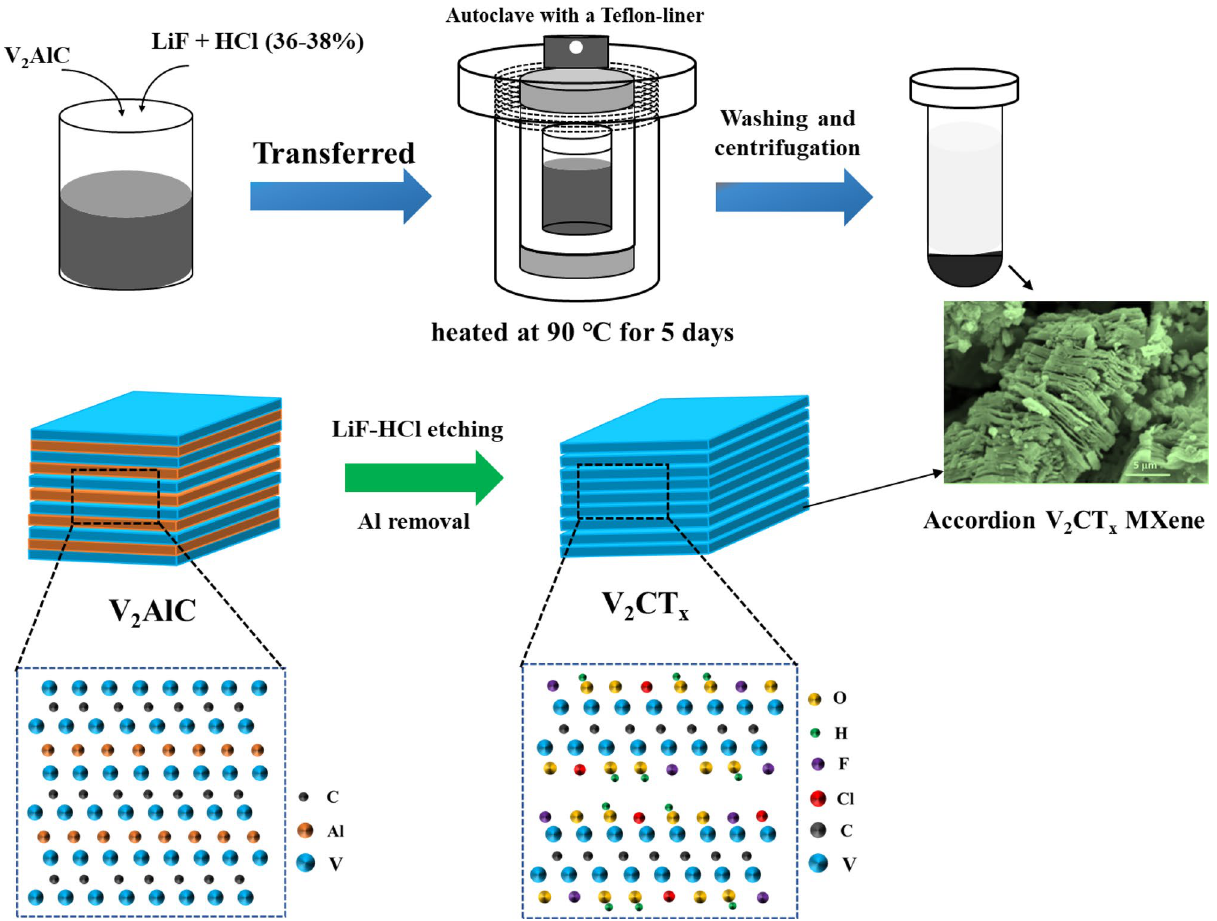
Figure 1. Schematic illustration of the synthesis process of accordion-like V 2 CT x MXene from V 2 AlC MAX- phase tively (as shown in Figs. 2 and 3). Figure 2a depicts the SEM image of the V 2 AlC MAX phase materials. As seen in the figure, the surface of the V 2 AlC MAX phase material comprised typical dense particles with no layer structures, while tiny particles (1–10 μm) were present on its surface. After the hydrothermal treatment with LiF-HCl etchant, typical accordion-like V 2 CT x MXenes with a few or multiple layers were formed (Fig. 2b–f). In Fig. 3d–e, high-magnification SEM images depict how Al-etching made interlayer spacings more apparent, with a gap of a few nanometers between the V 2 CT x MXene sheets. The particle size of the V 2 CT x MXene ranged from 1–20 μm, and the individual MXene sheets were connected. The elemental analysis of the as-prepared V 2 CT x MXene was also examined using EDX-Mapping analysis (Fig. 2g–k), by which the presence of C, V, F, and O was confirmed. The presence of a low-intensity Al signal may have been due to the continued presence of V 2 AlC, which was not etched. The XRD patterns of the V 2 AlC MAX phase and the pristine V 2 CT x MXene were also investigated, as shown in Fig. 3a. All diffraction peaks (shown in the red pattern) corresponded to the V 2 AlC phase (JCPDS, No. 29-0101) 24 . No other phase peaks were found in the pattern, indicating the high purity of the prepared V 2 AlC phase. The intensities of all peaks representing the MAX phase V 2 AlC decreased in the XRD patterns of the V 2 CT x phase, confirming the elimination of Al layers from V 2 AlC. Meanwhile, a broad peak appeared at a low angle (2θ = 7.33°), corresponding to the (002) plane of as obtained accordion-like V 2 CT x MXene 24 . The formation of the peak indicated the formation of MXene sheets. To investigate the morphology of the V 2 CT x MXene further, we performed TEM analysis as shown in Fig. 3b–c. It shows that 2D flake structures are stacked in a few single layers. Figure 3d shows the SAED pattern of V 2 CT x MXene, which demonstrated the polycrystalline nature of the prepared materials. Figure 3e-f shows the corresponding high-resolution TEM images of V 2 CT x MXene. Figure 3e shows an inter-planar spacing of 0.98 nm (002), while Fig. 3f shows lattice-fringes of 0.41 nm and 0.28 nm corresponding to (006) and (101) planes of V 2 CT x MXene. The prepared V 2 CT x MXene materials were annealed at different temperatures to produce MXene-derived hybrid structures and evaluate their sensing properties. The V 2 CT x MXene samples were calcined at 300, 350, and 450 °C in air. Hereafter, these samples are designated as V 2 C-300, V 2 C-350, and V 2 C-450, respectively. Morphological and structural analyses of the calcined V 2 C materials were also conducted using SEM and XRD.